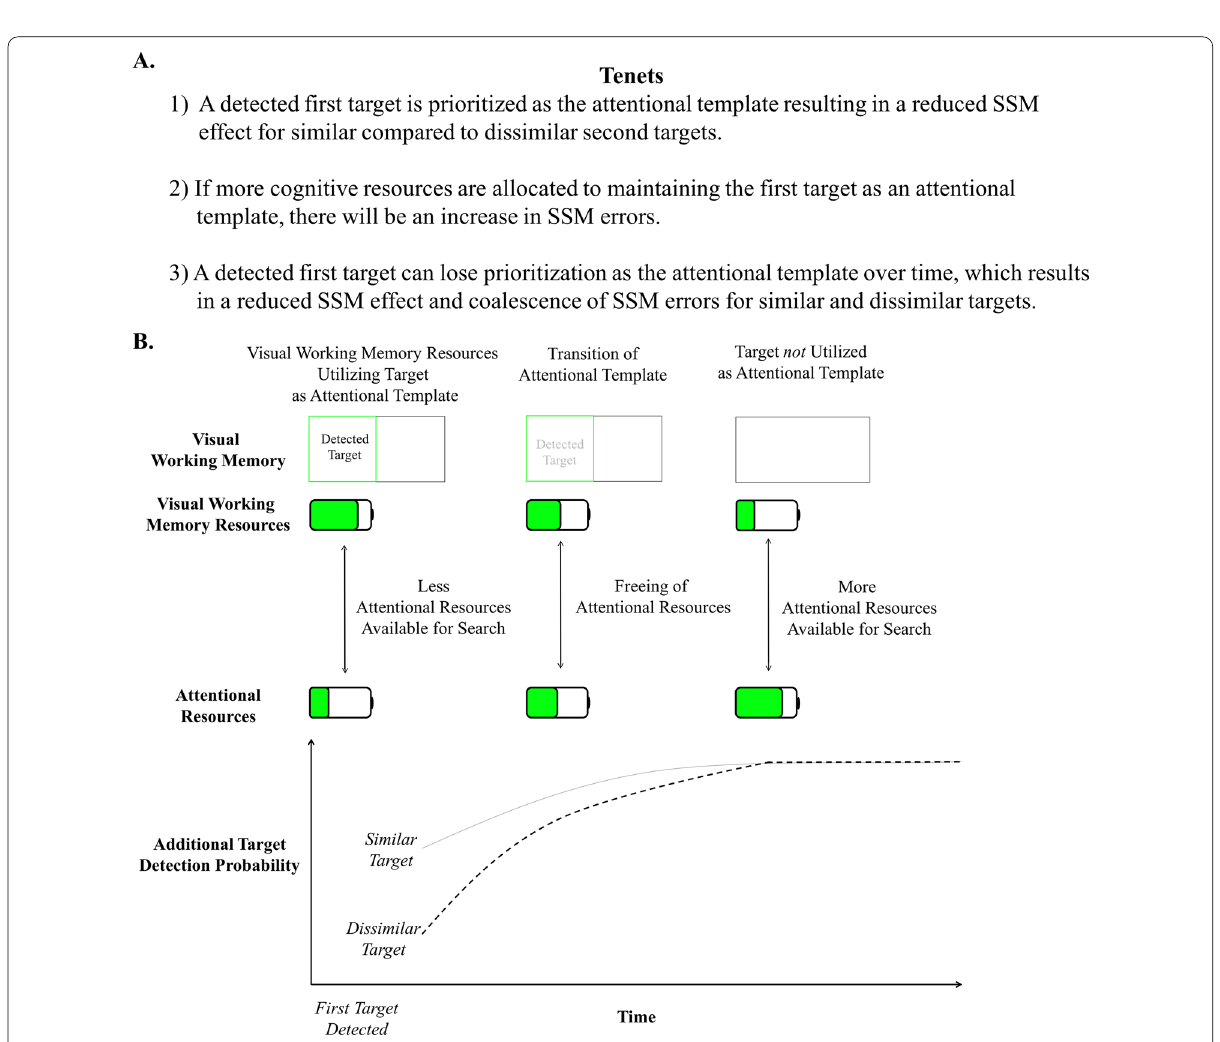
Fig. 2 A. Attentional Template Theory Tenets. The tenets of the Attentional Template theory were motivated by the SSM error literature and the broader visual working memory, attention, and visual search literature (see Tenets 1, 2, and 3 subsections below). B. Time Course of the Fluctuation of Working Memory and Attentional Resources. The battery illustration depicts the capacity limitations of visual working memory and attention. The double-sided arrows between the batteries illustrate the flow of a shared cognitive resource that underlies both visual working memory and attention, and that when one cognitive process is prioritized, the remaining cognitive process is hindered. After first target detection, visual working memory resources are prioritized to maintain the first target as an attentional template. Consequently, there are fewer attentional resources available, which will overall decrease the probability of additional target detection. Detection for similar targets after detecting a first target will be better compared to dissimilar targets because a first target attentional template will prime attention towards similar targets. Over time the first target may lose its prioritization as the attentional template, which will free up visual working memory resulting in improved and unbiased detection for similar and dissimilar